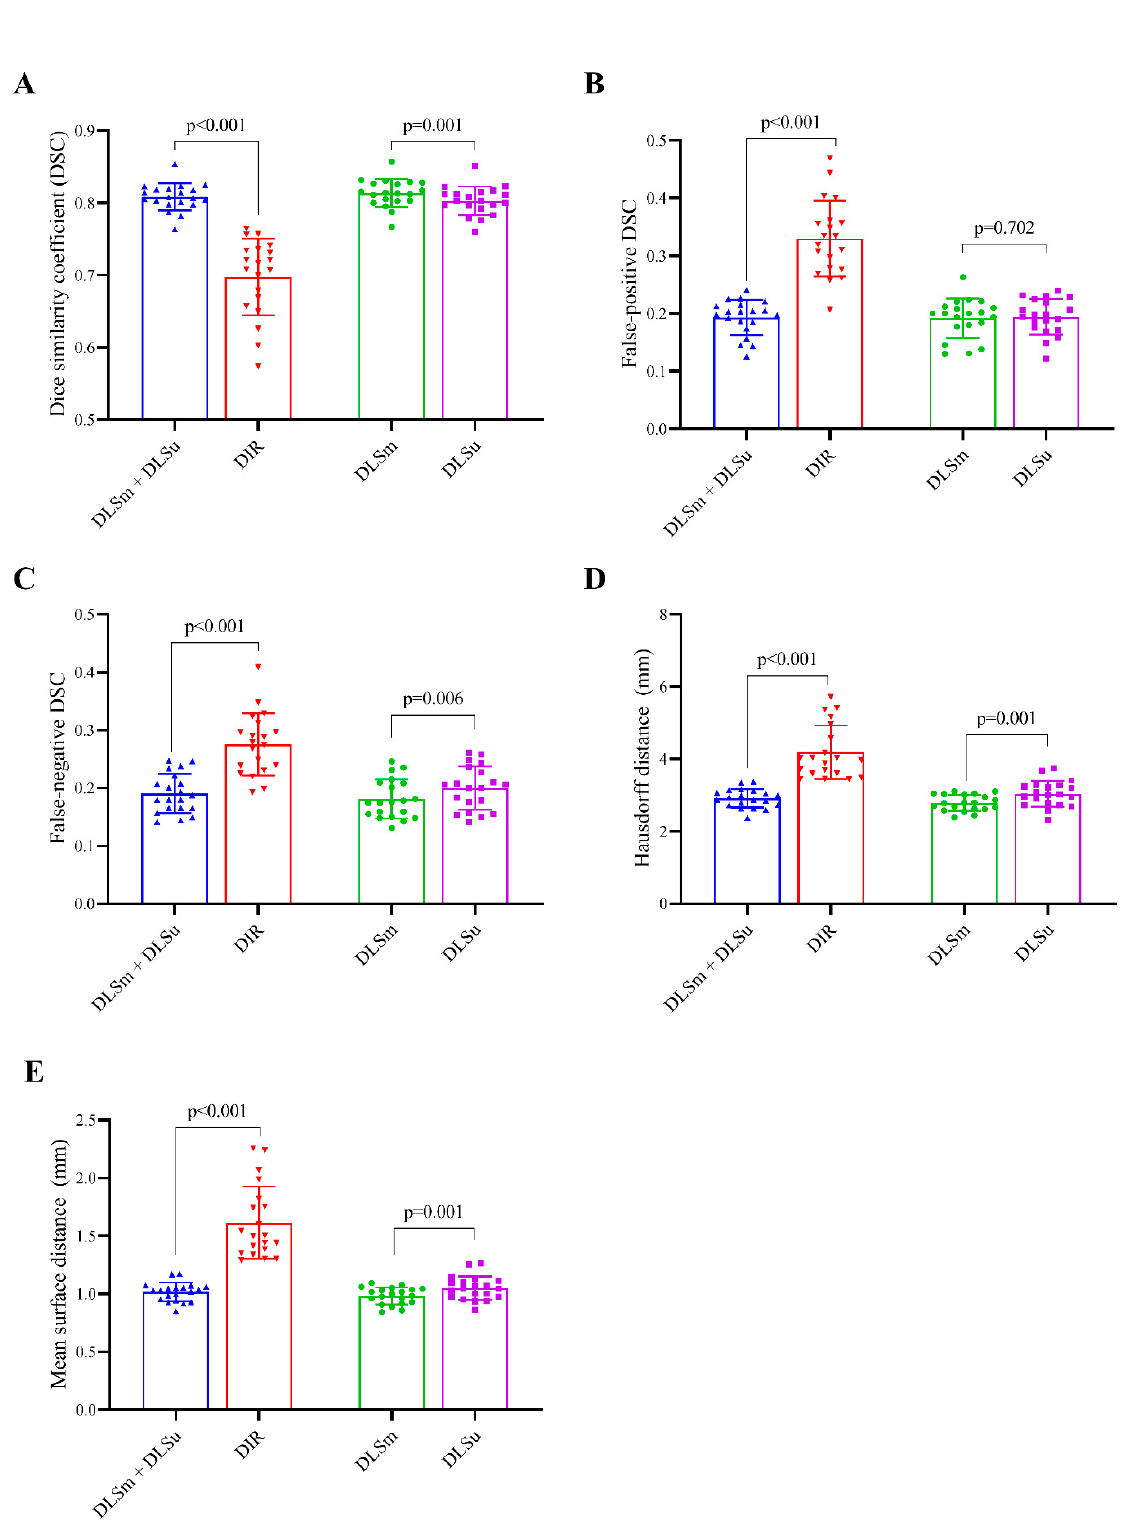
Figure 3. Median and interquartile range of average ( A ) Dice coefficient (DSC), ( B ) false positive Dice coefficient (FPD), ( C ) false negative Dice coefficient (FND), ( D ) Hausdorff distance (HD), and ( E ) Mean surface distance. Footnotes: DLSm + DLSu is defined as the average value of DLSm and DLSu , and mean surface distance (MSD). Abbreviations: DLSu, deep learning-based segmentation using the unmatched training set; DLSm, deep learning-based segmentation using the matched training set; DIR, segmentation from deformable image